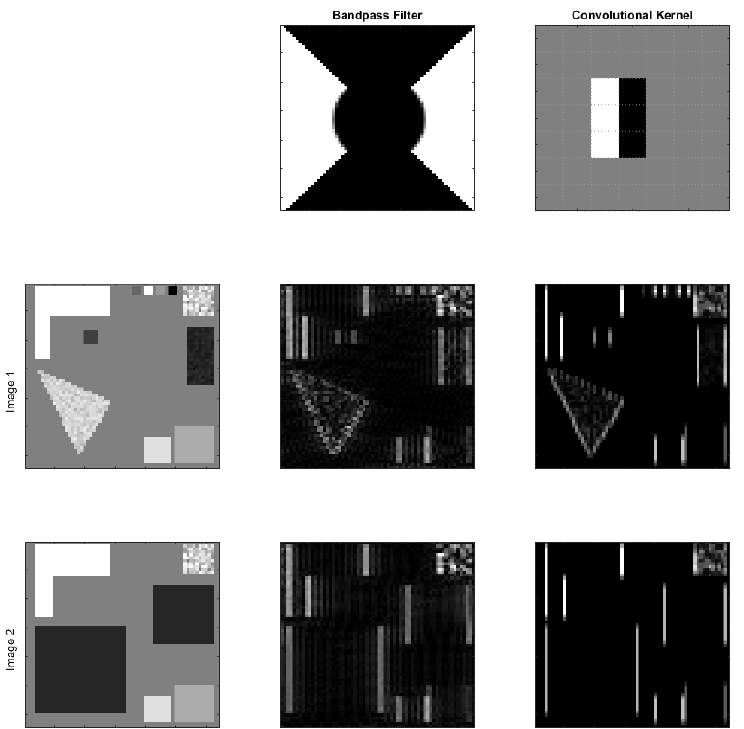
Figure 6. An example of how the features of a band-pass filter can be extracted using convolutional kernels, where the figure shows vertical image detection using a band-pass filter and convolutional kernel on two sample images.